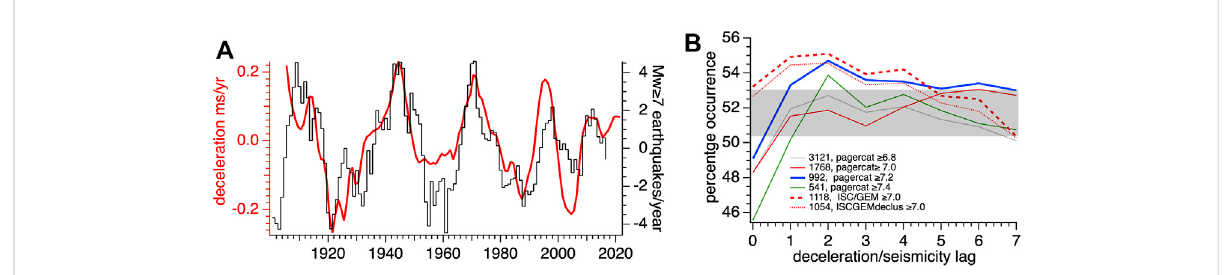
FIGURE 1 (A) . Earth ’ s angular deceleration (red) compared to global annual deviation in numbers of Mw ≥ 7 earthquakes each year (black PagerCat, Allen et al., 2009). Both time series are band-passed with the same 5-50 year fi lter and the deceleration data are plotted with a fi ve-year advance (from Bendick and Bilham, 2018). (B) . Lag between global numbers of earthquakes per year and angular deceleration time series for different seismic catalogs andmagnituderanges usingbinary mask (seetext). Wereearthquakesrandomly distributedintime we shouldanticipate eachcurveto lie within the shaded region of 51.7 ± 1.3% (Supplementary Material